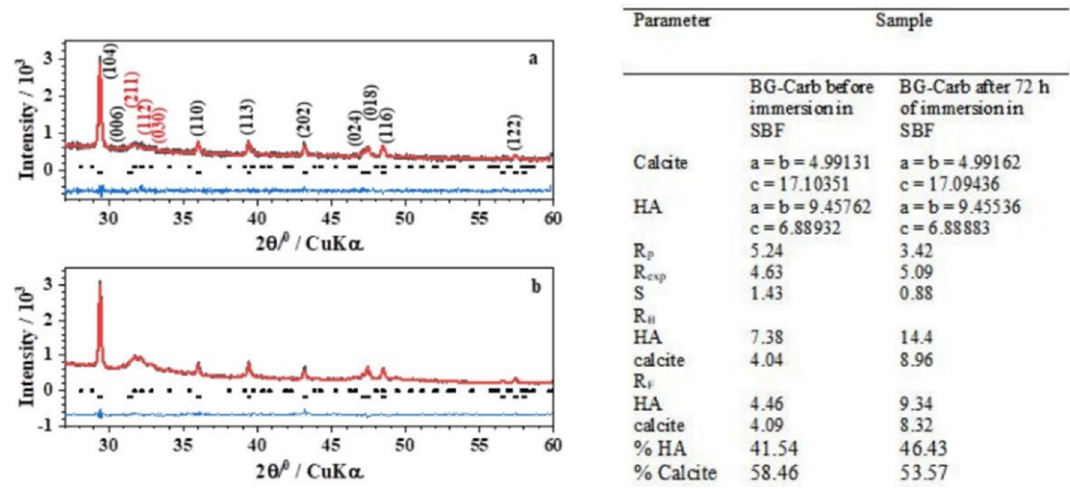
Figure 5. Left: Powder X-ray diffraction patterns (Black) of the BG-Carb samples ( a ) before and ( b ) after immersion in SBF solution for 72 h. The solid (Red) lines correspond to the profiles fitted through Rietveld refinement. The hkl indexes in black correspond to calcite phase, and those in red correspond to hydroxyapatite phase. Right: Structural parameters, Rietveld agreement factors, and phase compositions for the samples BG-Carb before and after immersion in SBF for 72